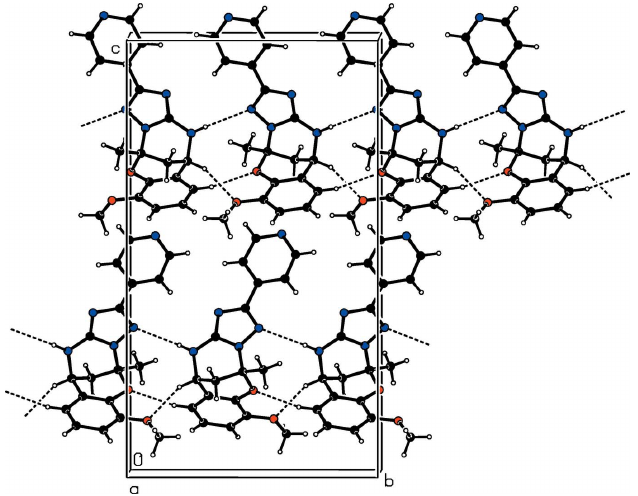
Figure 6 d norm mapped on Hirshfeld surfaces for visualizing the intermolecular interactions of ( a ) compound I and ( b ) compound II